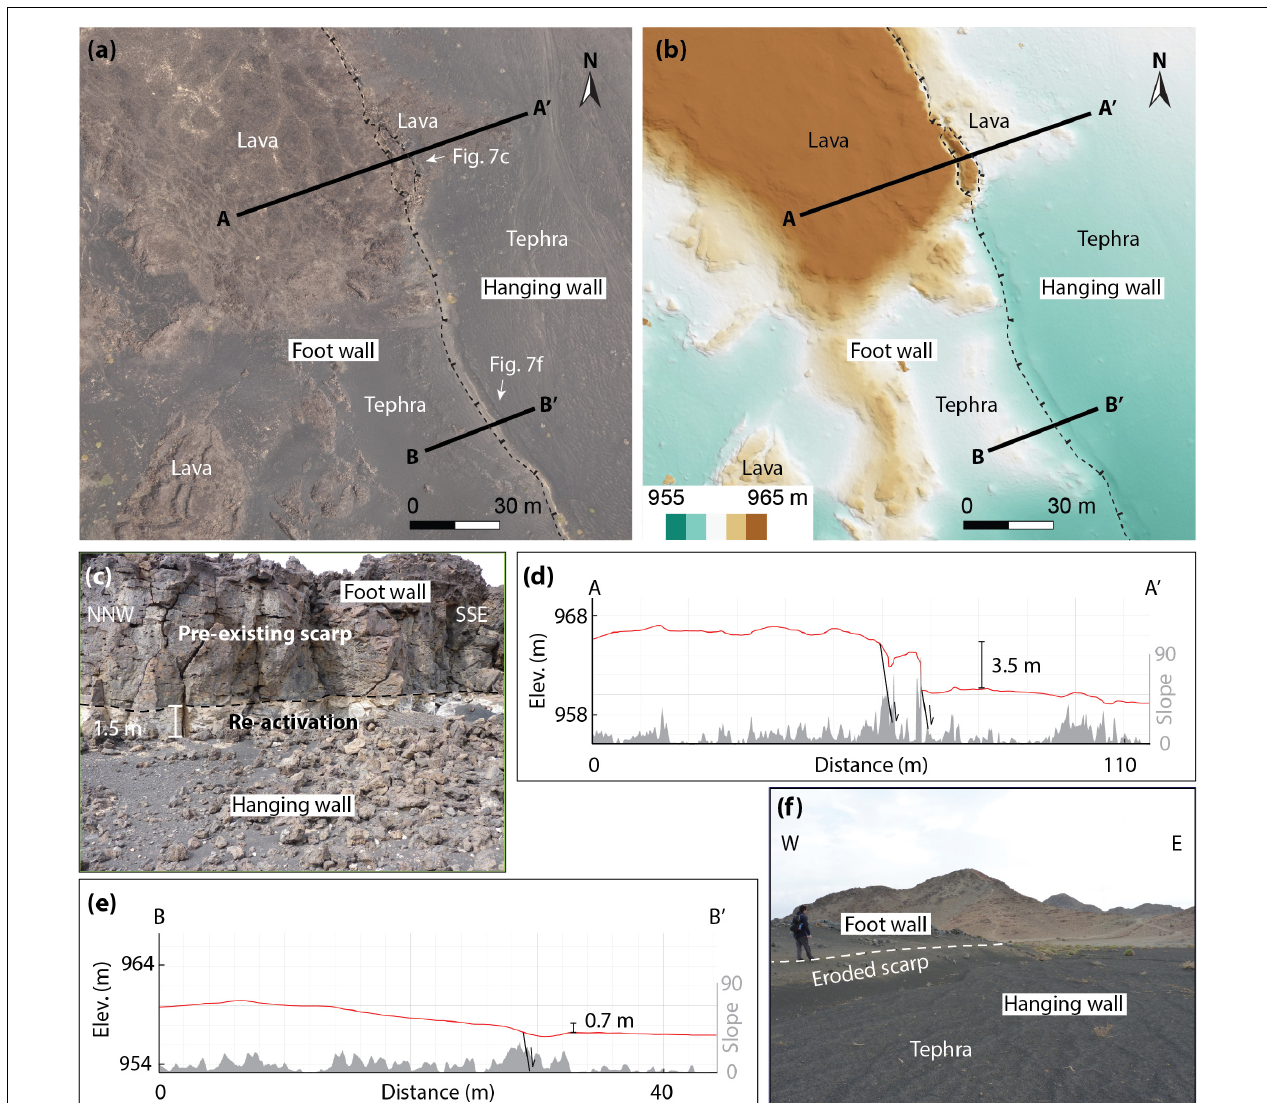
FIGURE 7 | Fault offsets and geometry in different lithologies for a portion of segment G along the western fault. (a) Ortho-photo and (b) DEM with the fault shown as a dashed line. Locations and azimuths of photos in (c) and (f) are indicated by white arrows. (c) Photo showing a pre-existing fault scarp (darker color) above a recently emerged portion of the fault (lighter color scarp) and a (d) topographic profile (red line) and slope values (gray) for A-A.’ (e,f) same as (c,d) . In (f) , the picture has been horizontally flipped in order to be consistent with the profile in (e) .